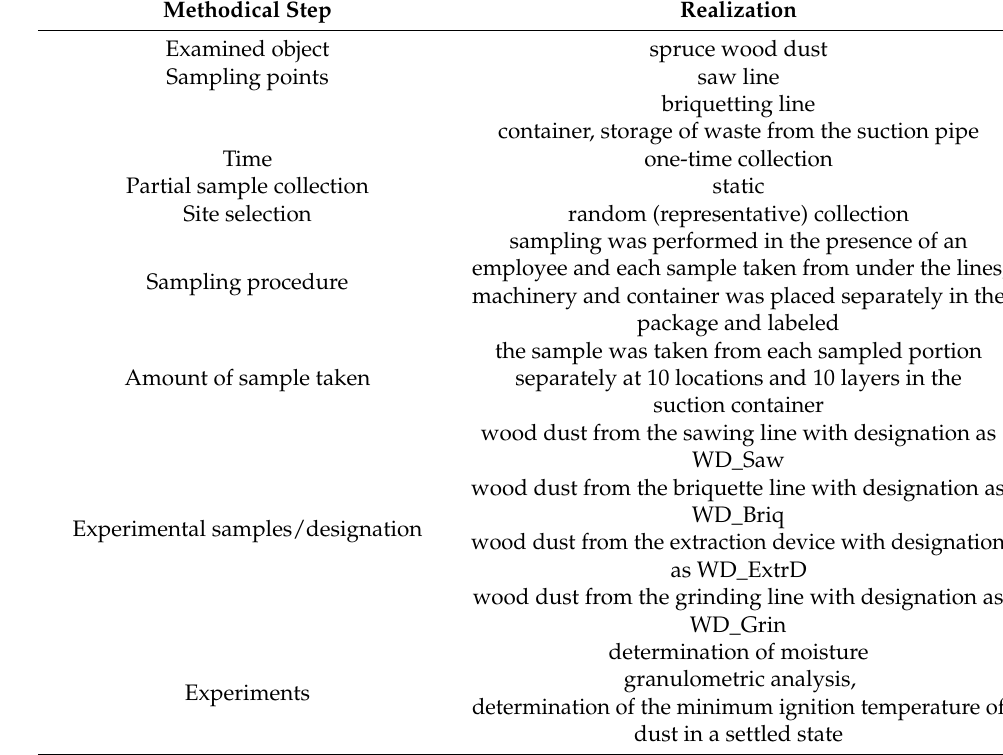
Table 1. Summary of the methodical procedure of spruce wood dust experiments.